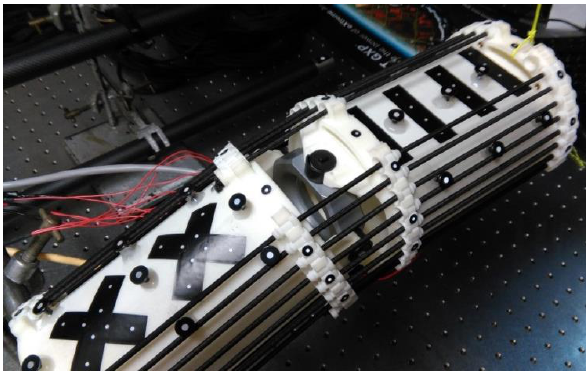
Figure 2. Prototype snake arm package